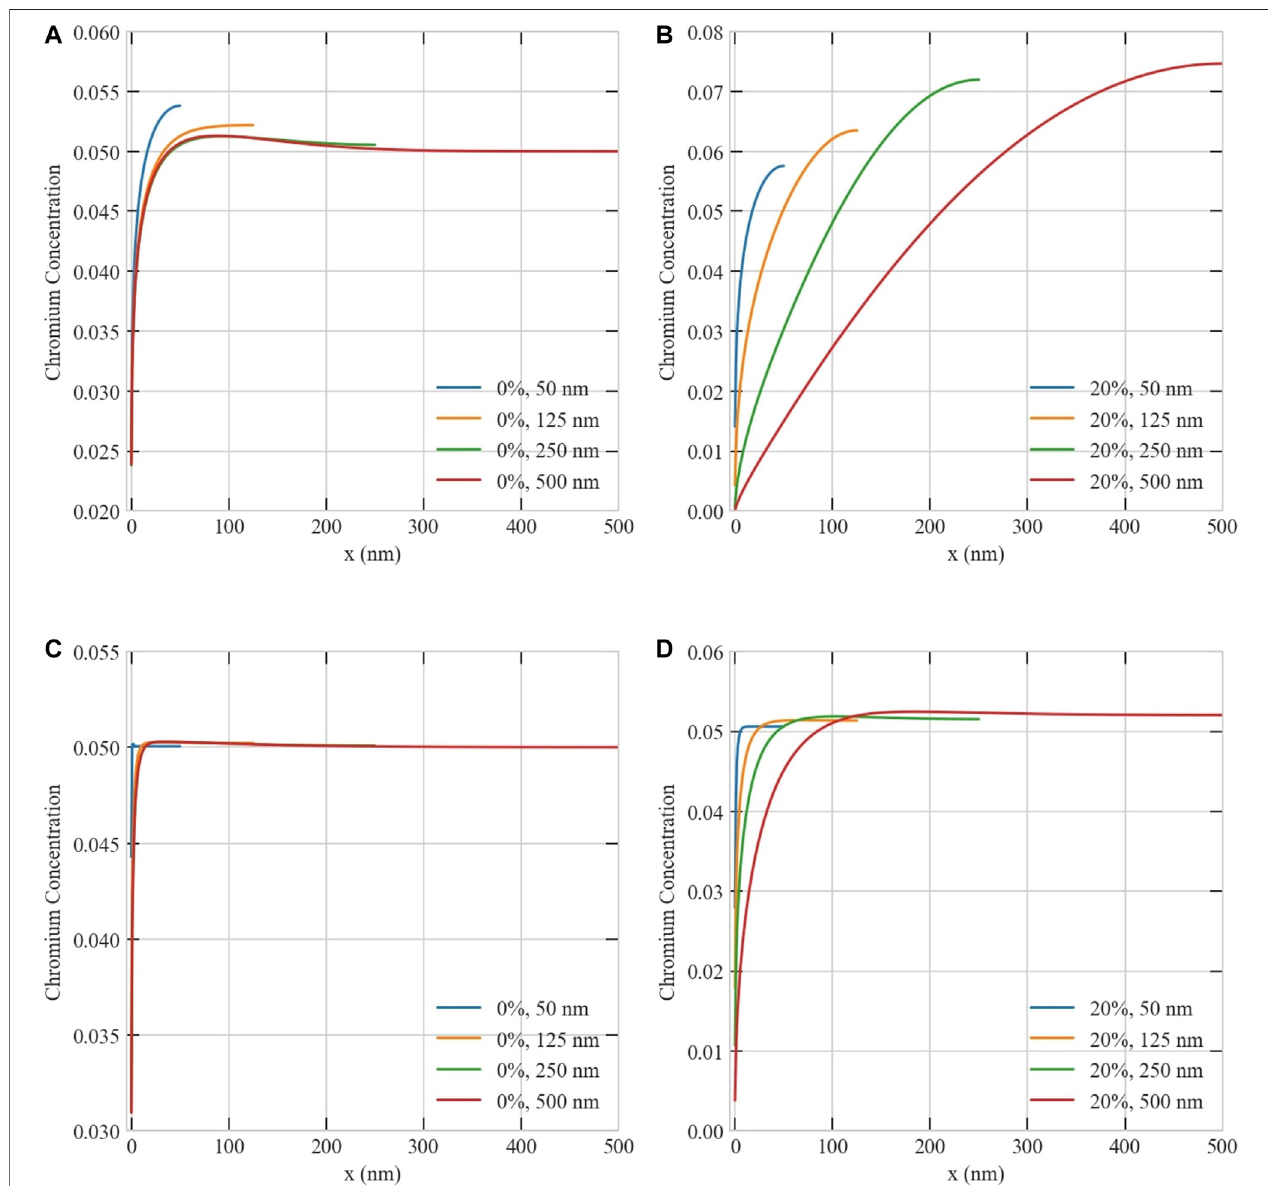
FIGURE 14 | Effect of grain size on the steady-state concentration pro fi les of Chromium. Upper row : concentration pro fi les of Chromium at 1e-3 dpa/s with productionbiasof (A) 0%and (B) 20%. Lowerrow :concentrationpro fi lesofChromiumat7e-6 dpa/swithproductionbiasof (C) 0%and (D) 20%.Similartothecaseof pure Ni (recall Figure 5 ),size effect saturates above ≈ 125 – 250 nm (depending on dose rate) in the absence of production bias, while itcontinues to become stronger in the presence of production bias. The depletion of Cr increases with production bias and size. This increase is more pronounced at higher dose rates.